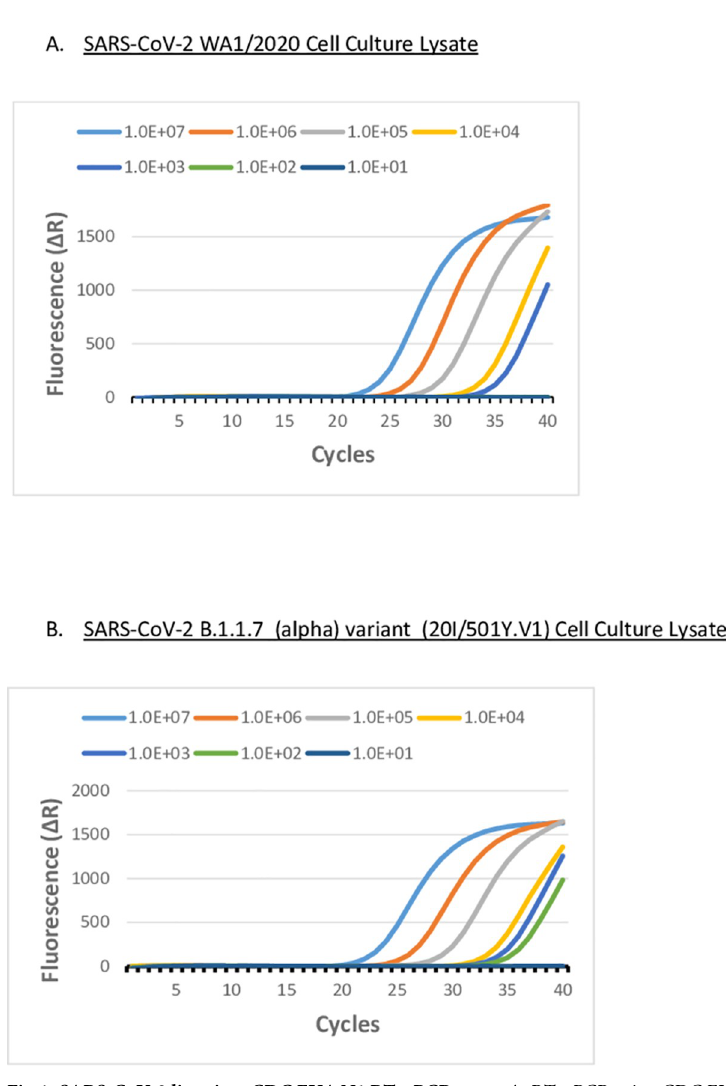
Fig 4. SARS-CoV-2 live virus CDC EUA N1 RT-qPCR assay. A. RT-qPCR using CDC EUA N1 probe assay targeting SARS-CoV-2 (WA1/2020) and, B. targeting SARS-CoV-2 B.1.1.7 (Alpha) (20I/501Y.V1) in infected Vero cells. Culture supernatants were log-serially ranging from 10 7 pfu/ml to 10 pfu/ml. RNA was purified from cell culture supernatants and reverse transcribed and cDNA was used in an RT-qPCR reaction in the CDC EUA N1 Probe Assay. Fluorescence data were collected and processed using a 40 cycle cut-off on an AriaMx Real-Time PCR System.